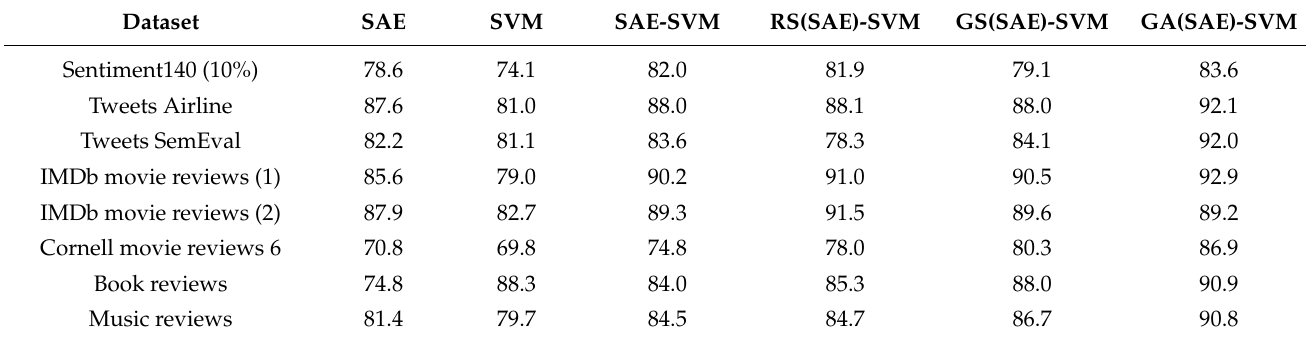
Table 9. Precision comparison for different types of datasets.